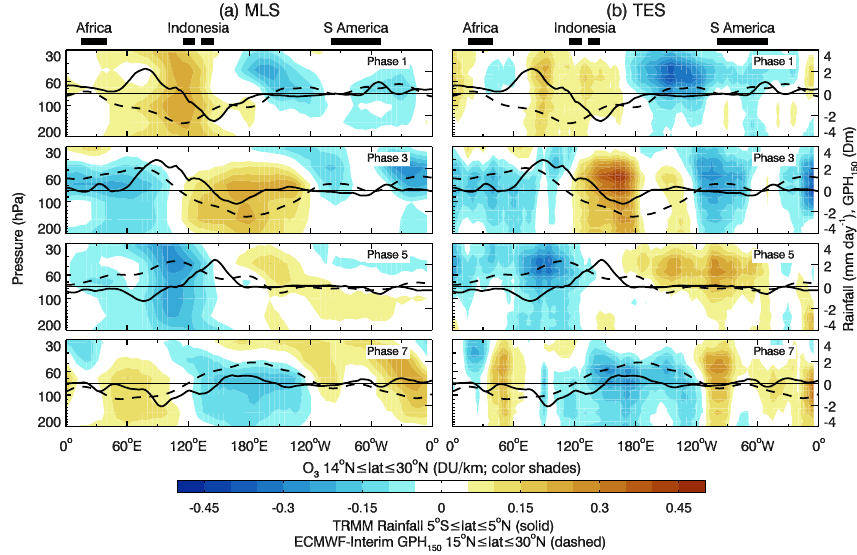
Fig. 7. Pressure-longitude cross sections of the MJO-related O 3 anomalies in the northern subtropics averaged between 14 ◦ N and 30 ◦ N from both MLS (a) and TES (b) . A 20 ◦ -longitude spatial running average has been applied to remove high-wavenumber fluctuations. Solid lines denote the MJO-related TRMM rainfall anomalies averaged between 5 ◦ S and 5 ◦ N. Dashed lines represent the MJO-related ERA-Interim GPH 150 anomalies averaged between 15 ◦ N and 30 ◦ N in unit of decameters (1Dm=10m).